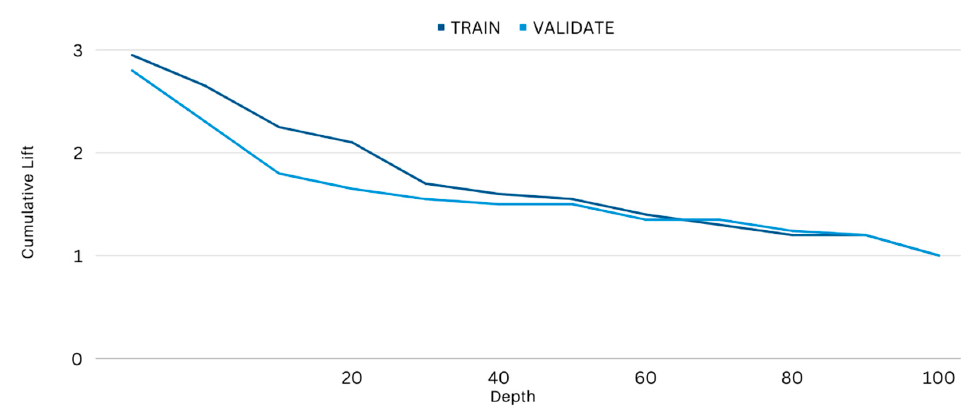
Figure 10. CR chart of statistical changes.